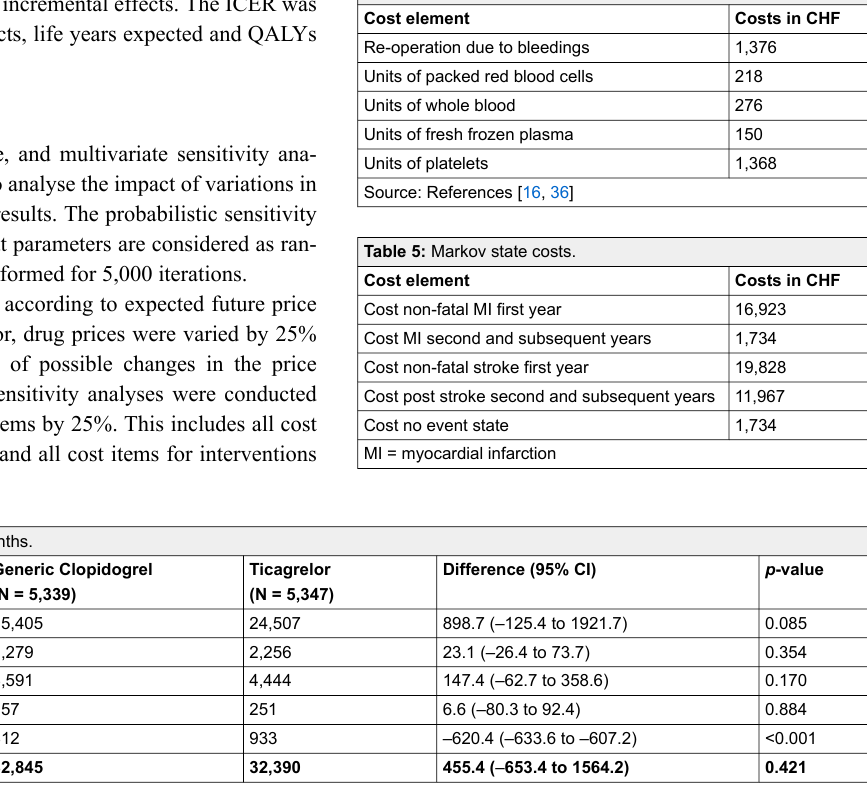
Table 4: Costs of re-operation due to bleeding.